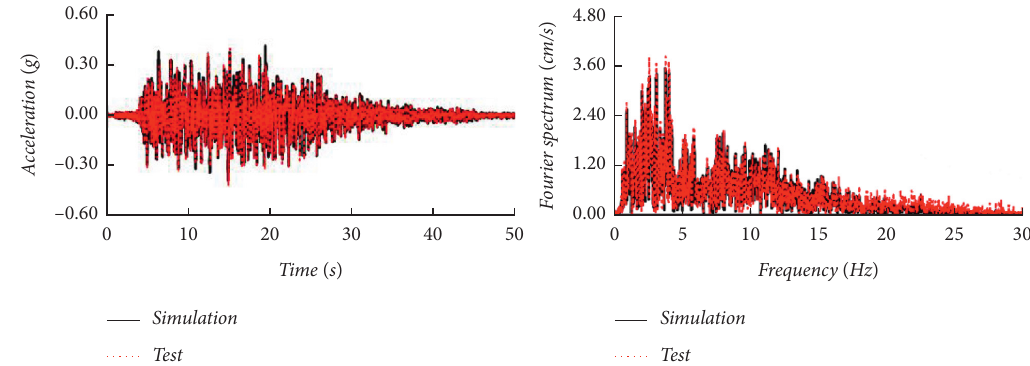
Figure 10: Acceleration response of model foundation.